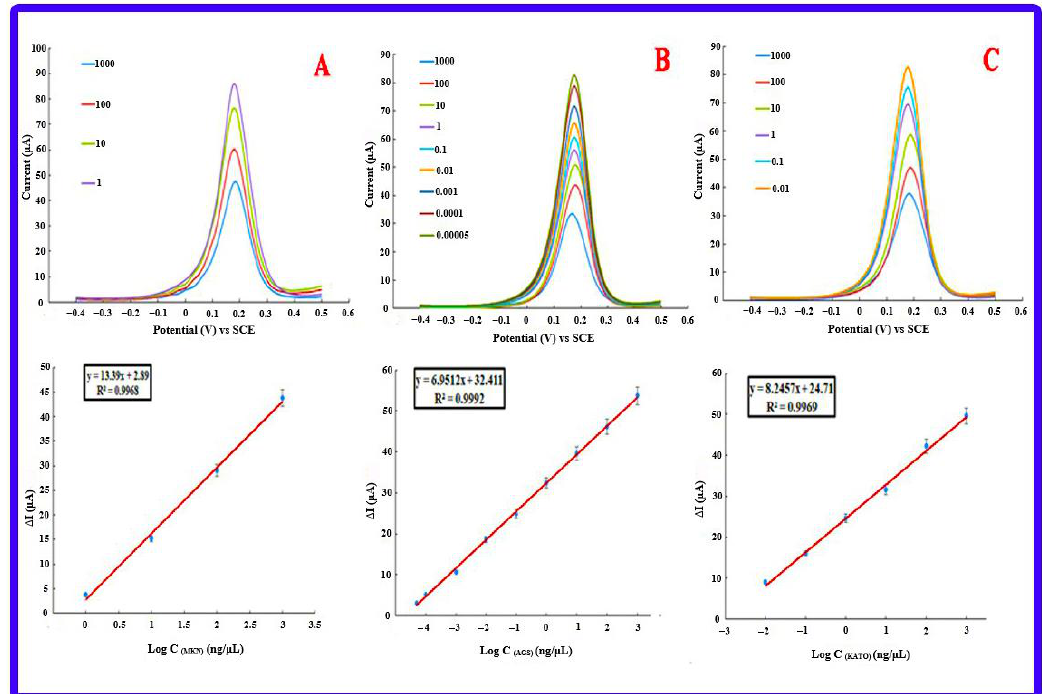
Figure 8. Electrochemical results of detecting different concentrations of miRNA-21 in cell lines ( A ) MKN-45 with a detection limit of 1 ng/µL, ( B ) AGS with a detection limit of 5 × 10 −5 ng/µL and ( C ) KATO III with a detection limit of 0.01 ng/µL.